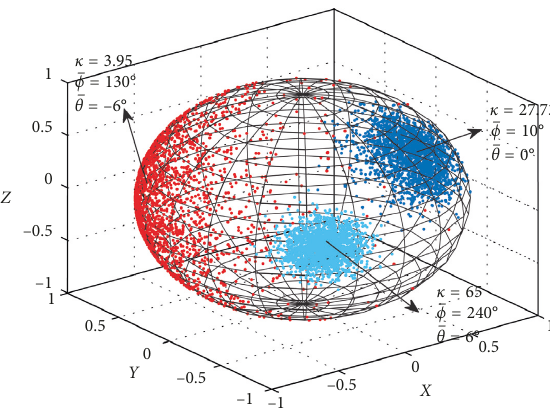
Figure 2: The VMF distributed angles on the unit